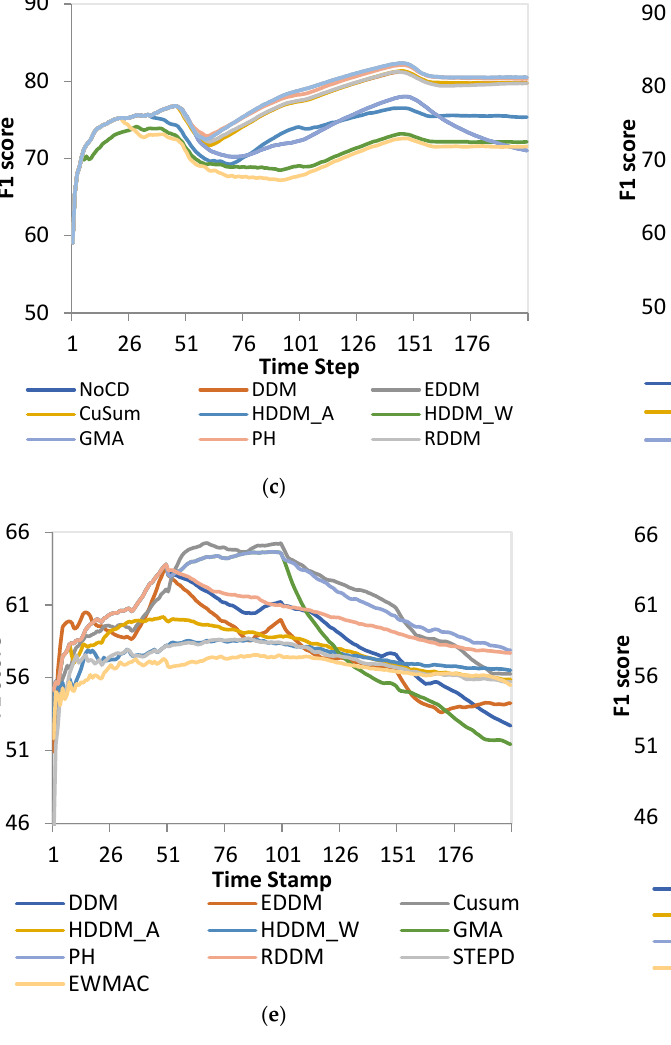
Figure 11. F1 score on each time step for all data streams: ( a ) performance of HT on balanced data with sudden drift; ( b ) performance of HT on imbalanced data with sudden drift; ( c ) performance of HT on balanced data with gradual drift; ( d ) performance of HT on imbalanced data with gradual drift; ( e ) performance of HT on balanced data with incremental drift; ( f ) performance of HT on imbalanced data with incremental drift. Table 5. Overall F1 score of HT classifier with different drift detection methods.